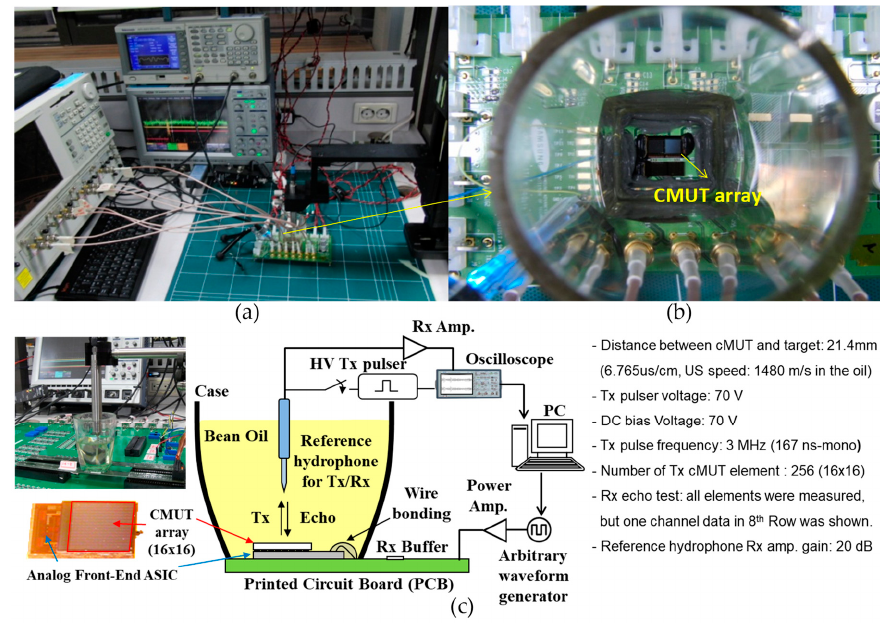
Figure 2. Experimental setup for CMUT array. Photos of ( a ) experimental environment and ( b ) 2-D CMUT-on-ASIC arrays, and ( c ) detailed block diagram and experimental conditions for Tx/Rx test with reference hydrophone.